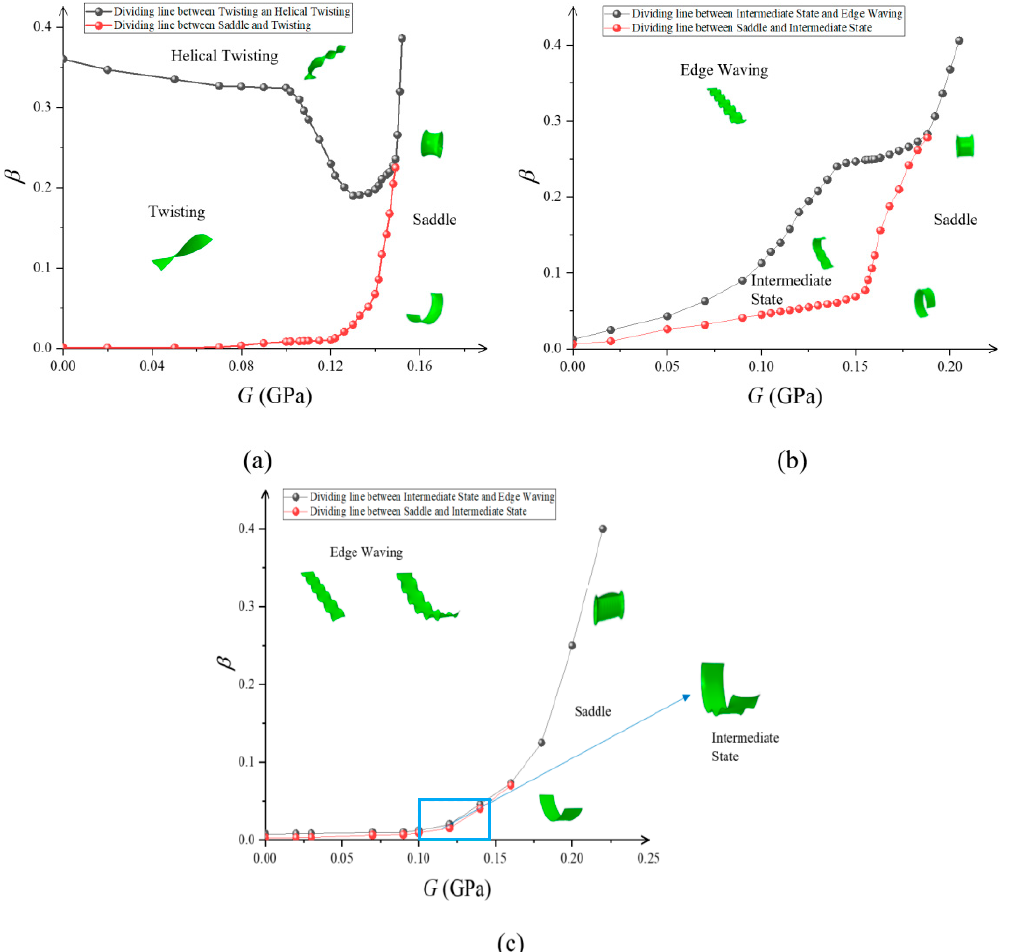
Figure 6. Phase diagrams of variation in the post-buckling morphology of orthotropic materials with intrinsic strain β under different principal shear modulus G : ( a ) when n = 2; ( b ) when n = 6; ( c ) when n = 10.